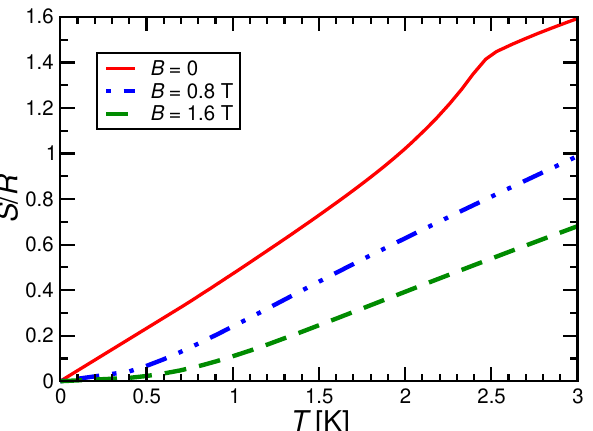
Figure 13. Magnetic entropy per mole of MnNi(NO 2 ) 4 (en) 2 in magnetic fields of B = 0, 0.8, and 1.6 T, respectively.